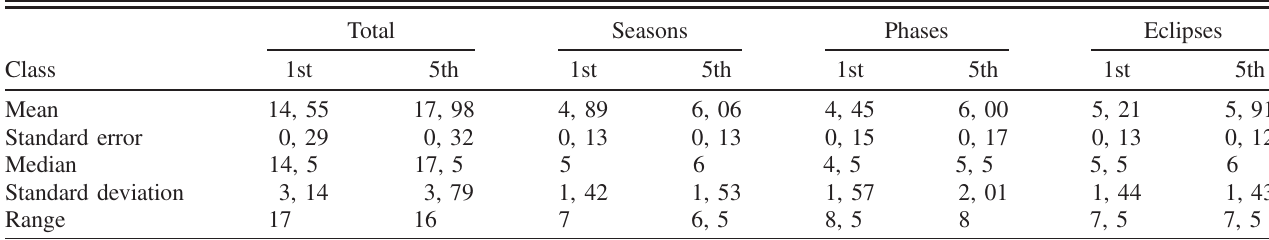
TABLE II. Basic statistics of the questionnaire.